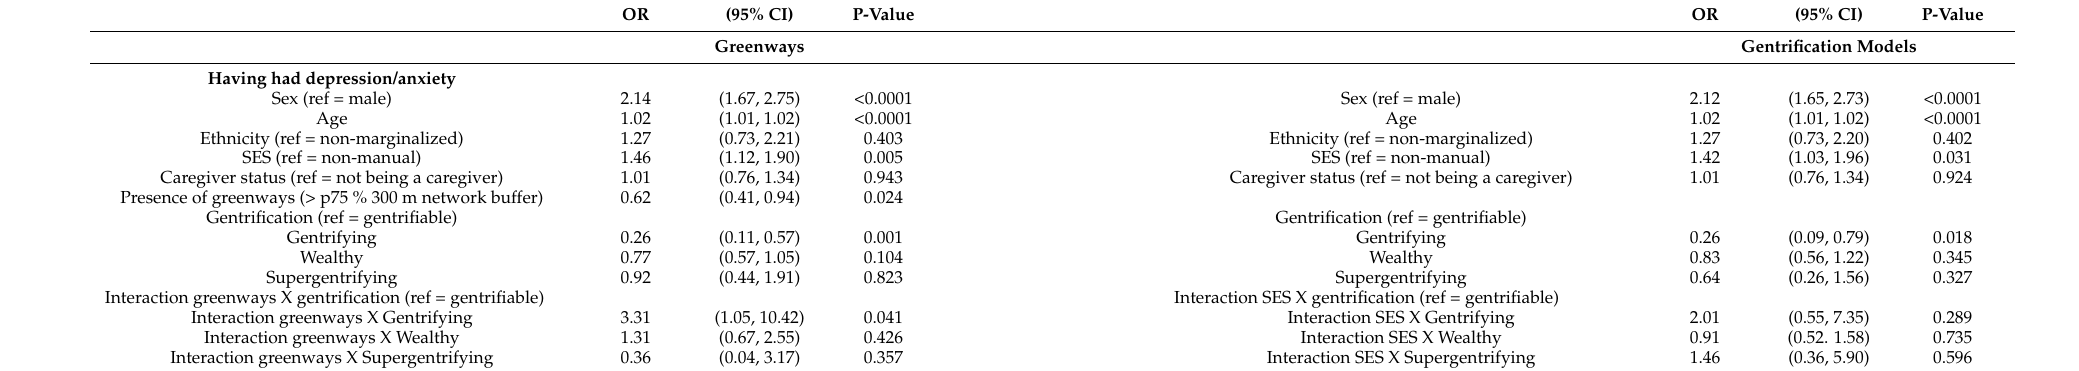
Table 3. Logistic regression models (weight-adjusted and spatial clustering) adjusted for sociodemographic variables (sex, age, ethnicity, socioeconomic status and caregiver status) with potential interactions between greenways X gentrification and SES X